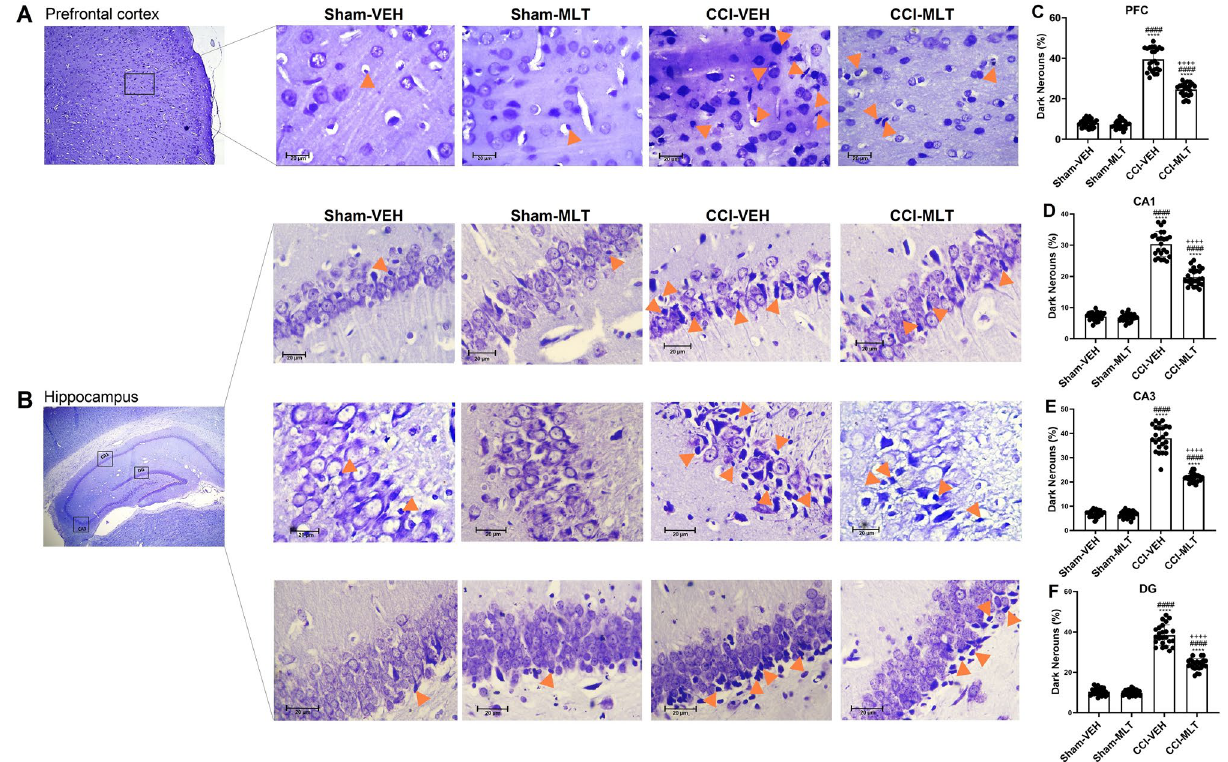
Figure 5. Effects of melatonin (MLT) on ( A ) the percentage of dark neurons in the hippocampus and prefrontal cortex (PFC) of chronic constriction injury (CCI)-induced rats. Nissl staining of ( A ) the PFC and ( B ) different parts of the HC (10× and 400×). Arrows show the basophilic and shrunken cells known as dark neurons. Comparing the percentage of dark neurons in the ( C ) PFC, ( D ) CA1, ( E ) CA3, and ( F ) DG among different groups. **** P < 0.0001 compared with the Sham-VEH group; #### P < 0.0001 compared with the Sham-MLT group, and ++++ P < 0.0001 compared with the CCI-VEH group. Sham-VEH: sham-operated animals,